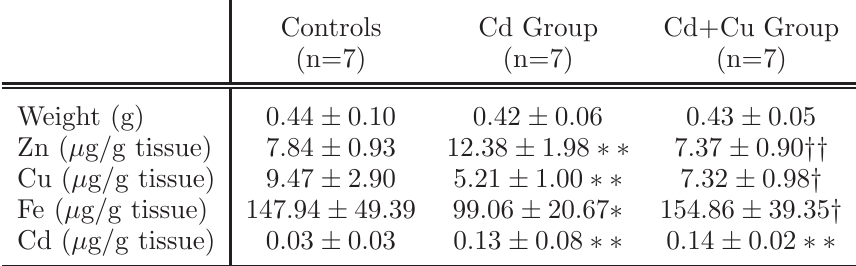
Table 1 Comparisons of placental weights and element levels (mean ± SD).